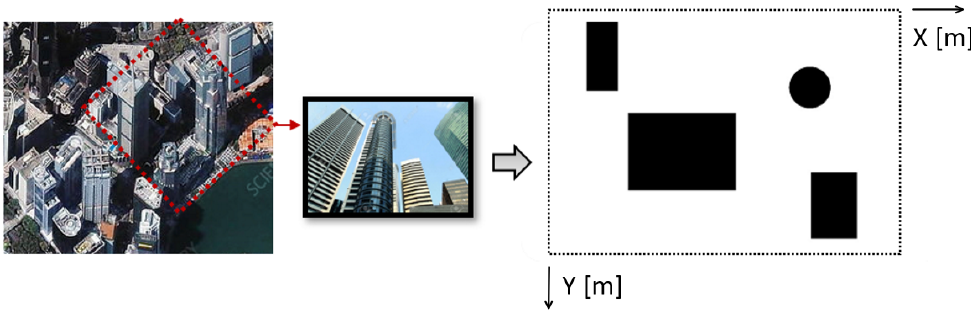
Figure 1. Example of a reconstruction of a simplified two-dimensional map starting from a urban